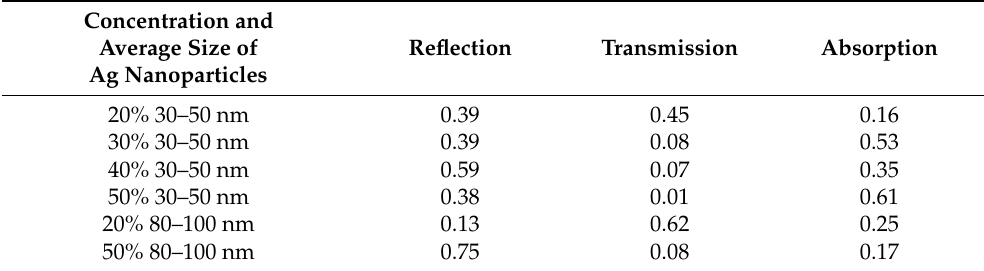
Figure 4. Frequency spectra of the complex dielectric permittivity real and imaginary parts for phosphate ceramics with Ag nanoinclusions in microwave frequency range at room temperature. Table 1. Reflection, transmission and absorption of phosphate ceramics with Ag nanoinclusions of 2 mm thickness calculated at 30 GHz.